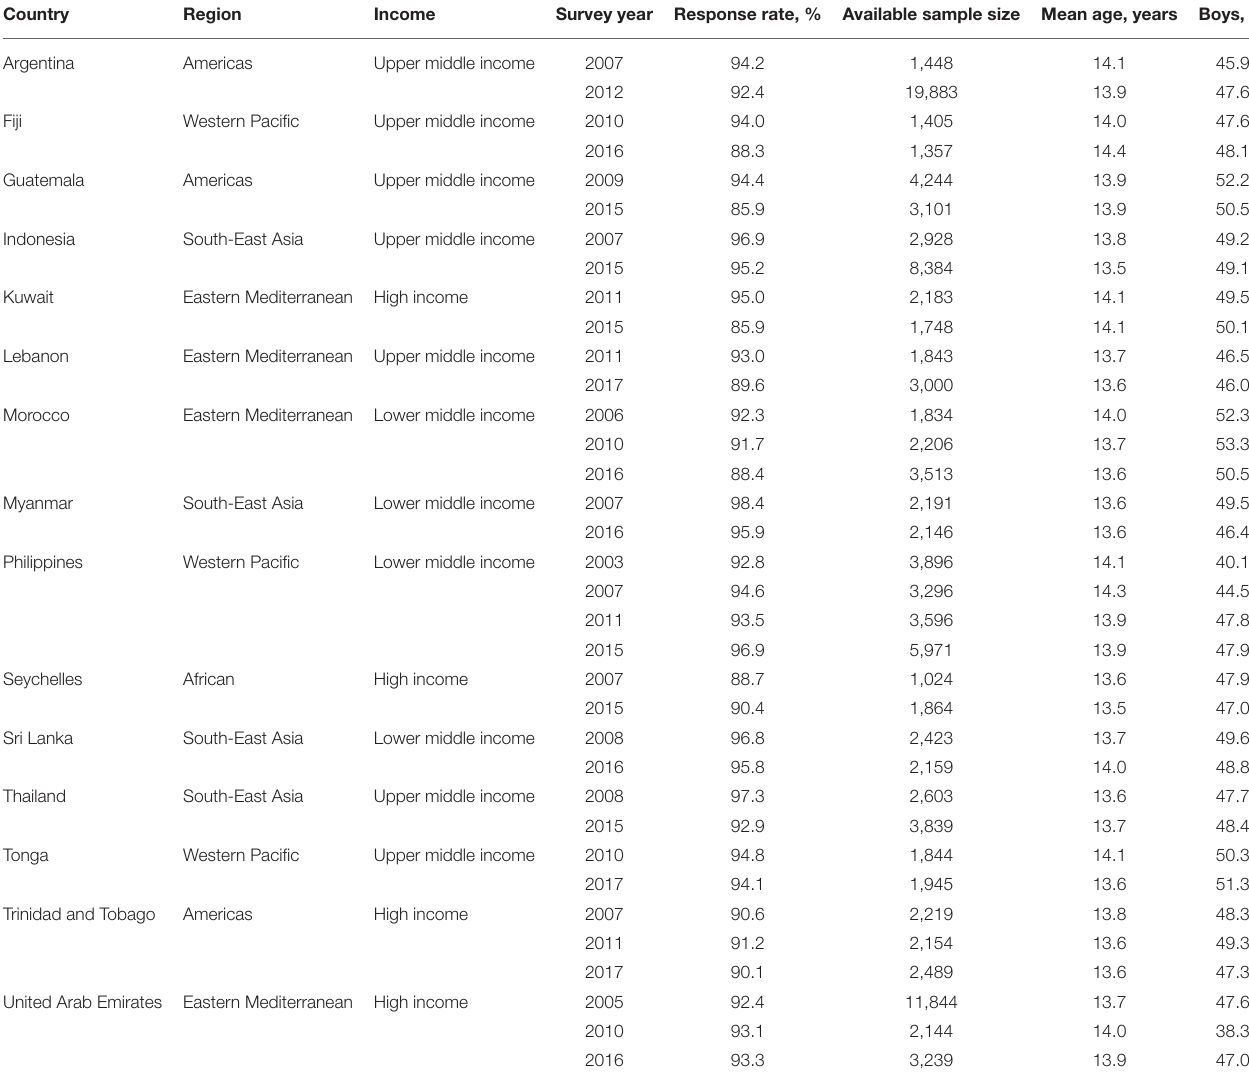
TABLE 1 | Survey characteristics in 15 countries.